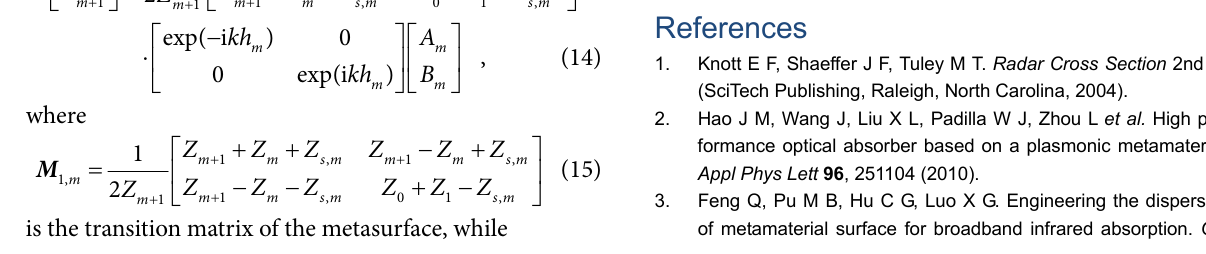
Fig. 8 | Schematic of the acoustic multilayer. In each layer, there are two counter-propagating waves with amplitudes of A and B . These amplitudes are connected with matrix shown in the